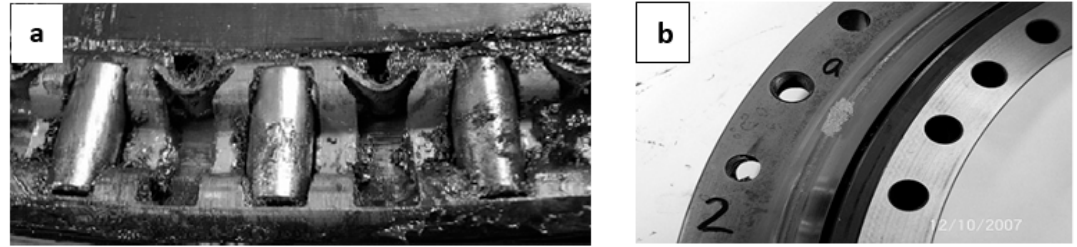
Figure 16. ( a ) A photo of damaged axial rollers; ( b ) A photo of outer raceway damage.